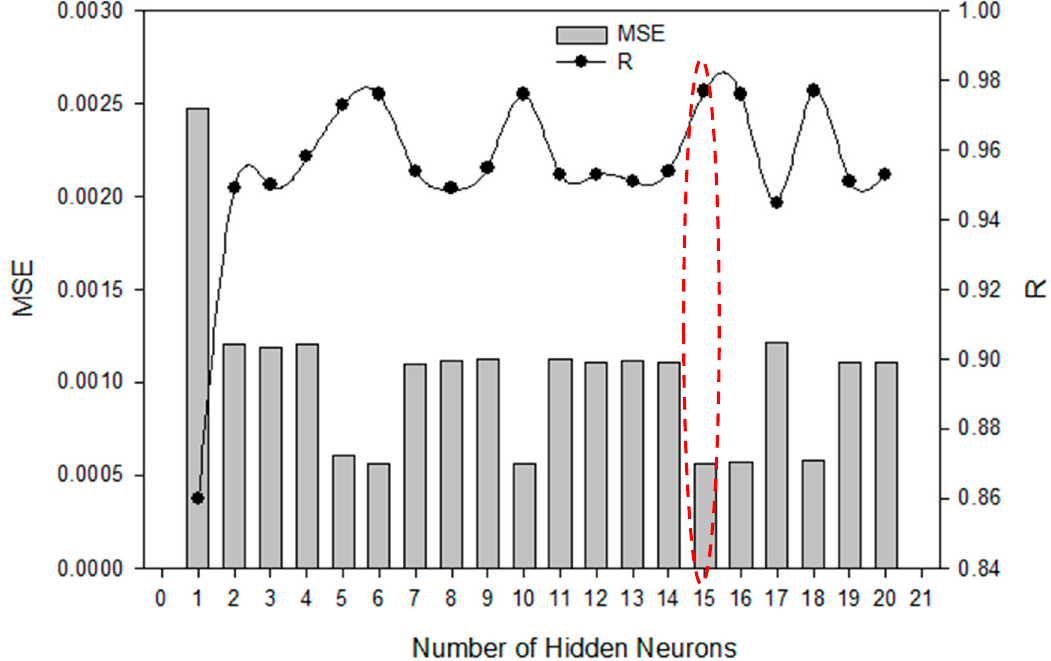
Figure 4. Determination of the optimized hidden neuron with the minimum MSE for ANN training using the Bayesian regularization algorithm.